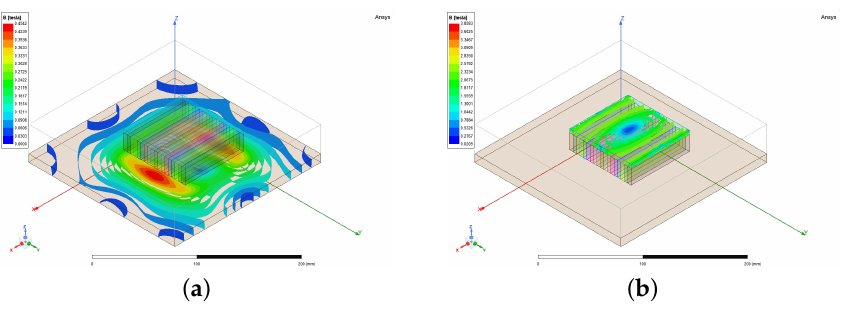
Figure 10. Simulation results for sinusoidal magnetization. ( a ) Cloud map of the magnetic flux intensity on the test steel plate. ( b ) Cloud map of the magnetic flux intensity on the